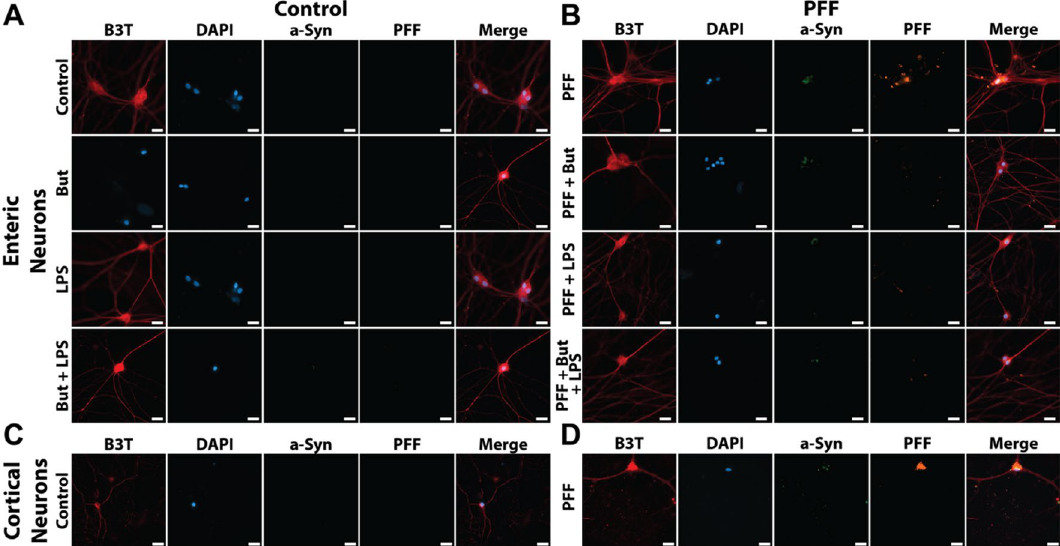
Figure 3. Representative images of neuron populations following 21 days of culture. ENS cultures were co-administered with LPS and/or butyrate either ( A ) alone (control), or ( B ) with PFFs. ( C ) Untreated cortical neurons. ( D ) PFF-dosed cortical neurons. (red = beta 3-tubulin (B3T), blue = DAPI, green = aggregated α-synuclein (a-Syn), orange = preformed fibril fluorescent tag). Scale = 20